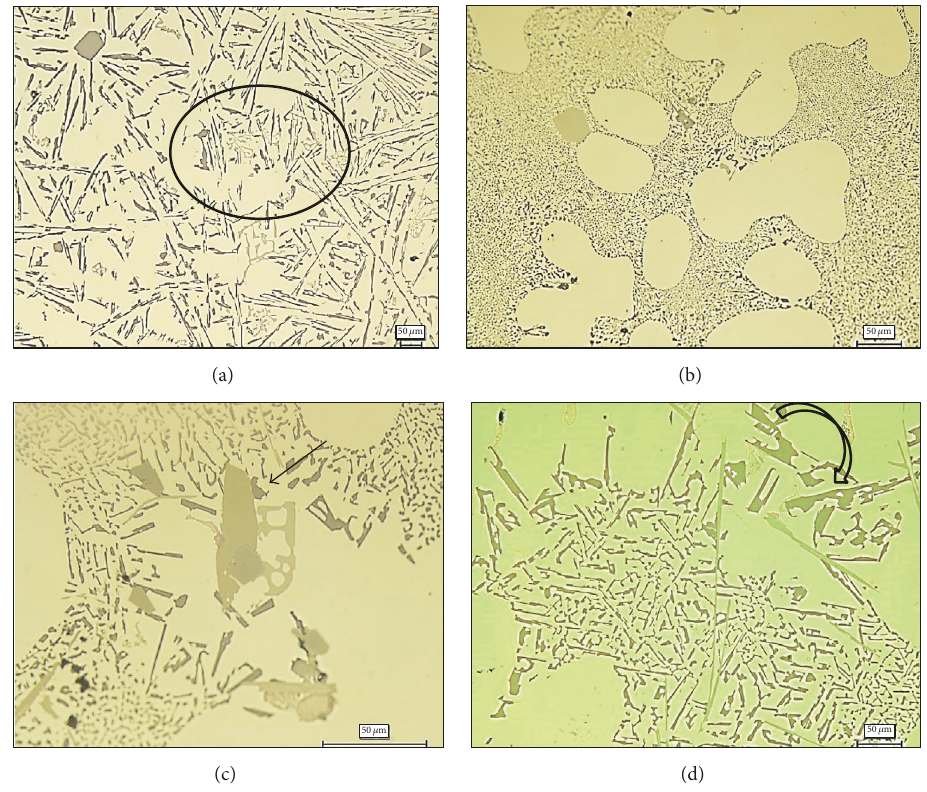
Figure 14: Optical micrographs of the eutectic Si particles in (a) TE alloy, (b) TES alloy, (c) TE3S alloy, and (d) TE9S